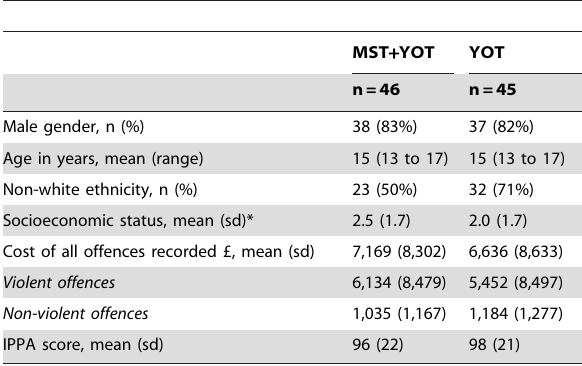
Table 1. Baseline characteristics of the MST + YOT and YOT samples included in the economic